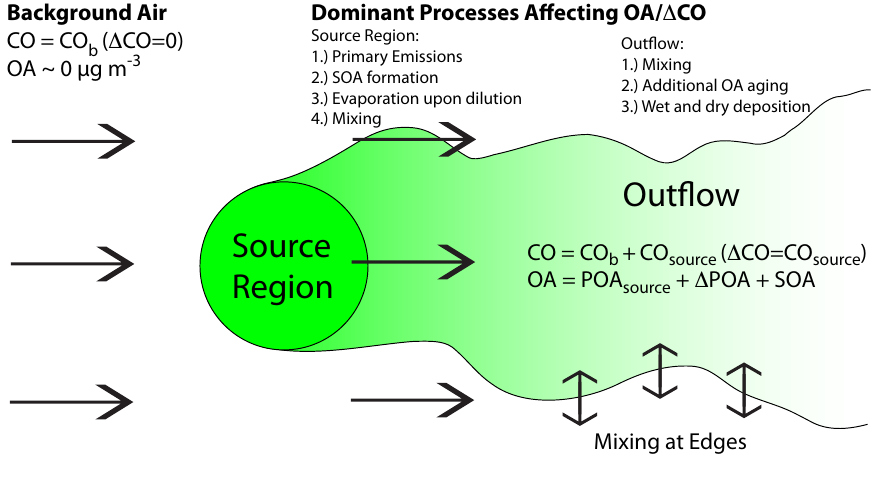
Fig. 1. A conceptual schematic for the application of the OA/ 1 CO method, and the interpretation of the CO background for the present